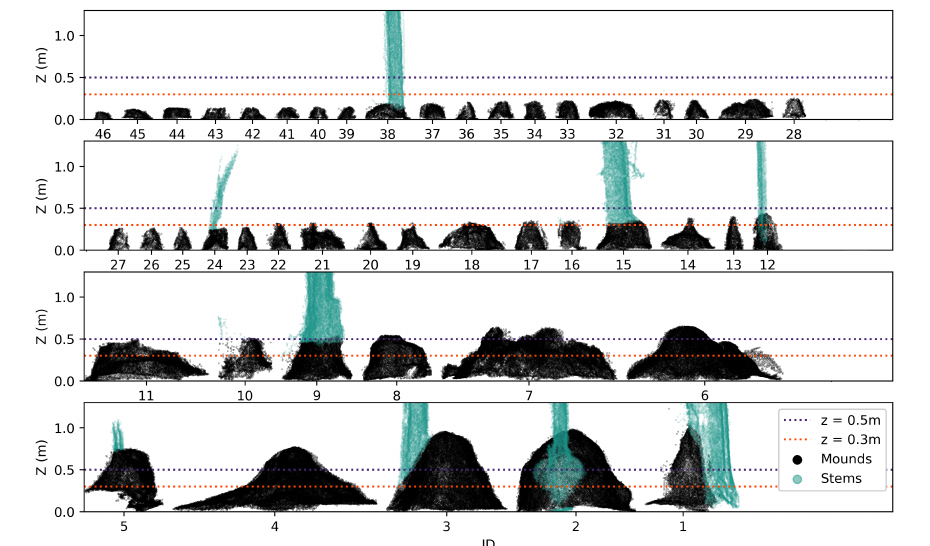
Figure 9. A visualisation of all detected termite mounds in the 1 ha benchmark data set that could be manually identified, ordered according to their height. The Y-axis represents the height above terrain, while the X-axis represents the front view of the mounds. The axes are equally scaled. Our focus is termite mounds > 0.5 m